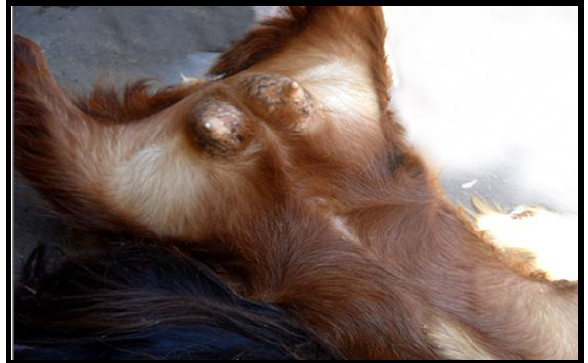
Figure, 3: No change in the udder halves of goat morphology of the 1st group that with CPG-ODN then HKCn Ag along the study.